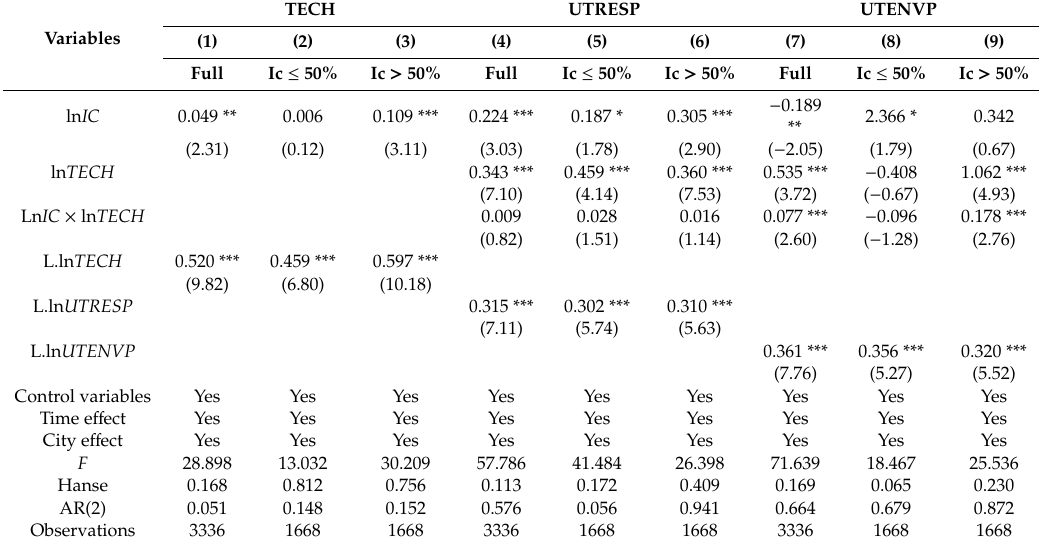
Table 5. Technology innovation and di ff usion e ff